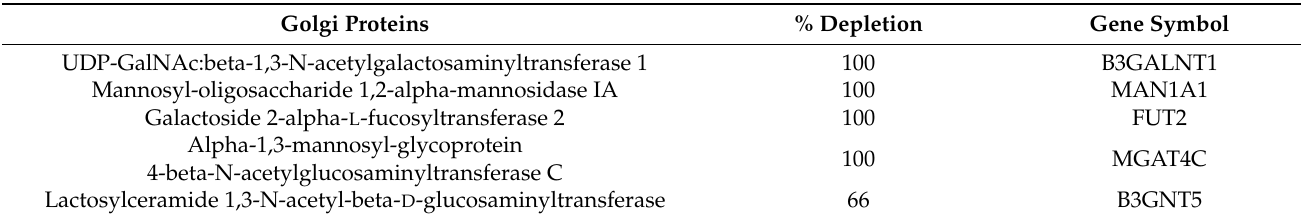
Table 2. Proteomic analysis of Golgi protein depletion by